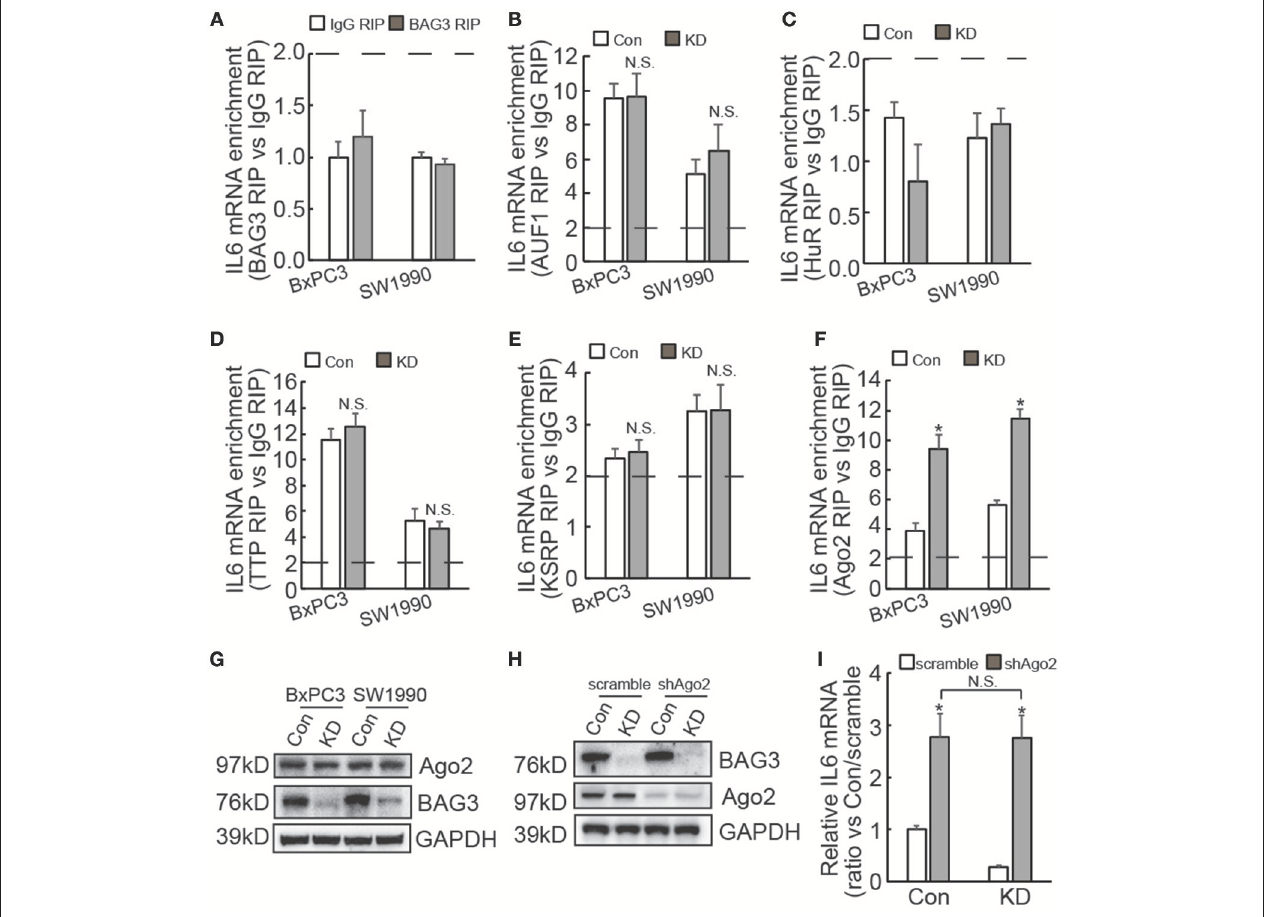
FIGURE 5 | BAG3 knockdown destabilizes IL6 mRNA in a miRNA-depdendent manner. (A–F) RIP was performed using BAG3 (A) , AUF1 (B) , HuR (C) , TTP (D) , KSRP (E) , or Ago2 (F) antibody with lysates from control or BAG3 knockdown PDAC cells. IL6 mRNA enrichment was analyzed using real-time RT-PCR. (G) Ago2 expression was analyzed using Western blot analysis. (H) Ago2 was knocked down using lentivirus containing shRNA against Ago2 (shAgo2), knockdown efficiency was confirmed using Western blot. (I) and IL6 mRNA expression was analyzed using real-time RT-PCR. N.S., not significant; * P <